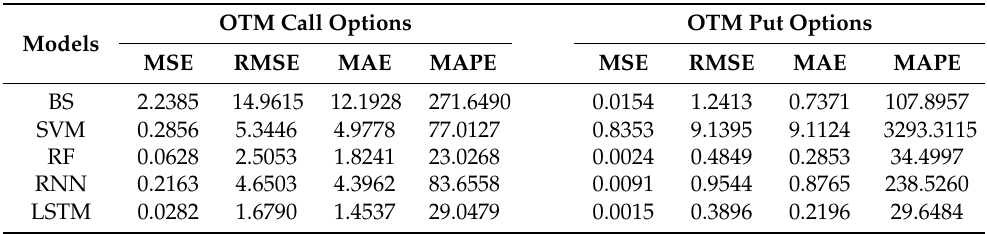
Table 13. Pricing error of OTM options estimated using different models when using realized skewness and realized kurtosis.